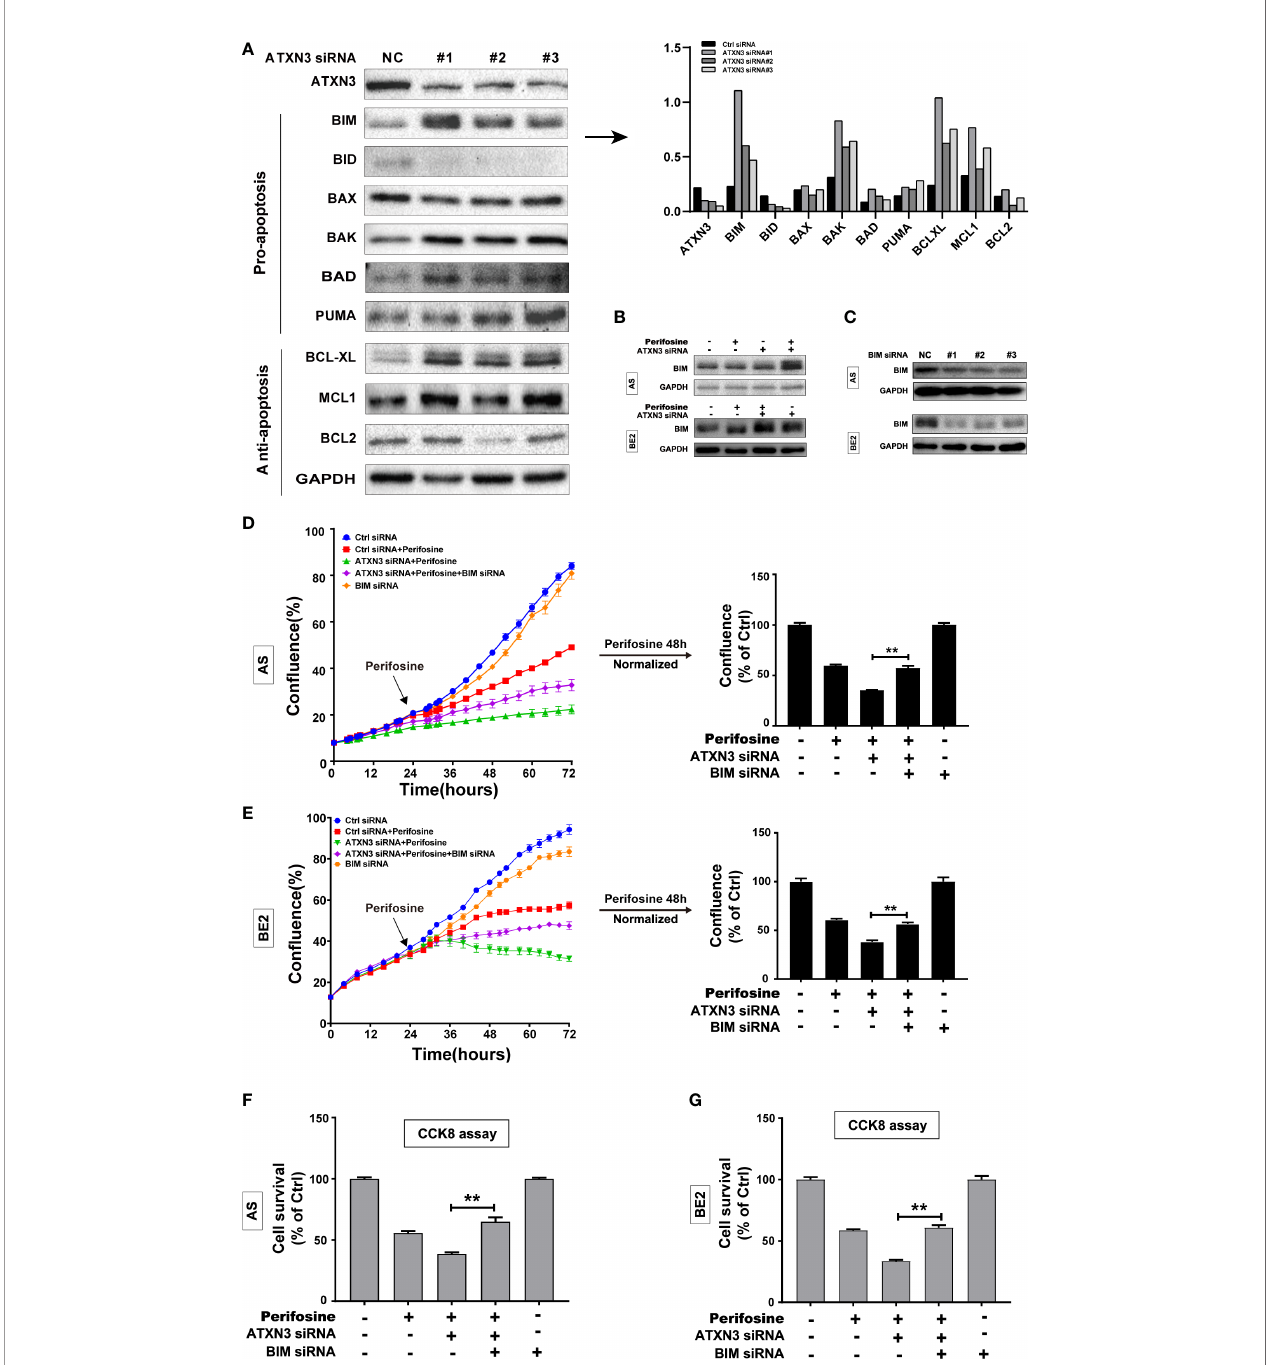
FIGURE 2 | BIM mediated the cell death induced by a combination of perifosine treatment and ATXN3 downregulation in NB cells. (A) ATXN3 was down-regulated by ATXN3 siRNAs transfection in AS cells for 48 h, the expression of ATXN3 and BCL2 family members was detected by Western blot (left), and the protein quantitative analysis was performed (right); (B) AS and BE2 cells were transfected with ATXN3 siRNA #2 (marked as ATXN3 siRNA) for 16 h and treated with perifosine for 24 h, the expression of BIM was detected by Western blot; (C) AS and BE2 cells were transfected with BIM siRNAs (#1, #2, and #3) for 48 h, and the expression of BIM was detected by Western blot. BIM siRNA #1 (marked as BIM siRNA) and ATXN3 #2 (marked as ATXN3 siRNA) were transfected into AS and BE2 cells alone or combination, then these cells were treated with perifosine for 48 h; (D, E) The con fl uence was detected by IncuCyte Zoom; (F, G) Cell survival was detected by CCK8 assay. Bar, SD, **P < 0.01, ATXN3 siRNAs + perifosine + BIM siRNA vs. ATXN3 siRNA + perifosine.